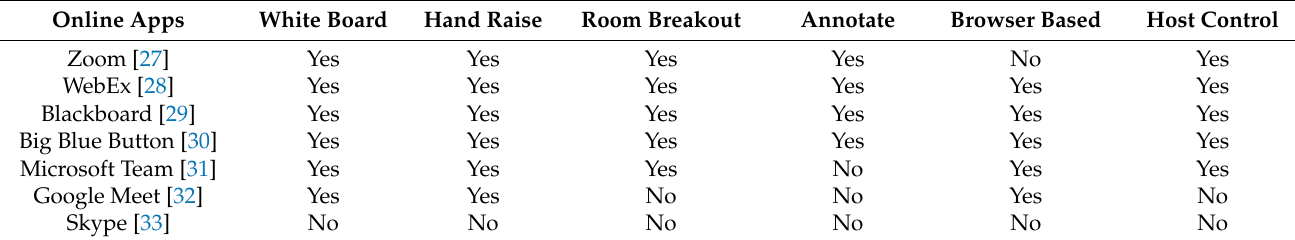
Table 1. The features provided for each video